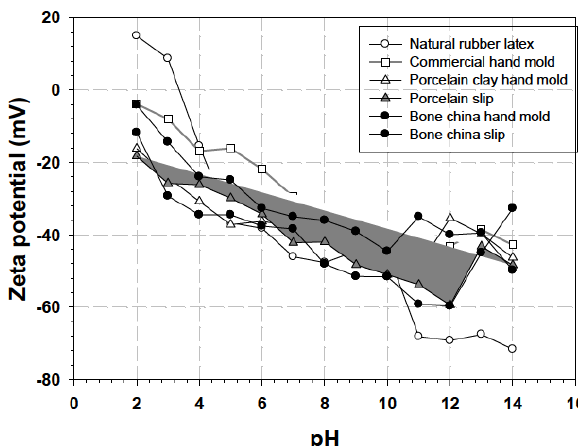
Figure 5: FTIR spectra of raw clay powder, fired porcelain and bone china clay hand molds, and commercial ceramic hand molds